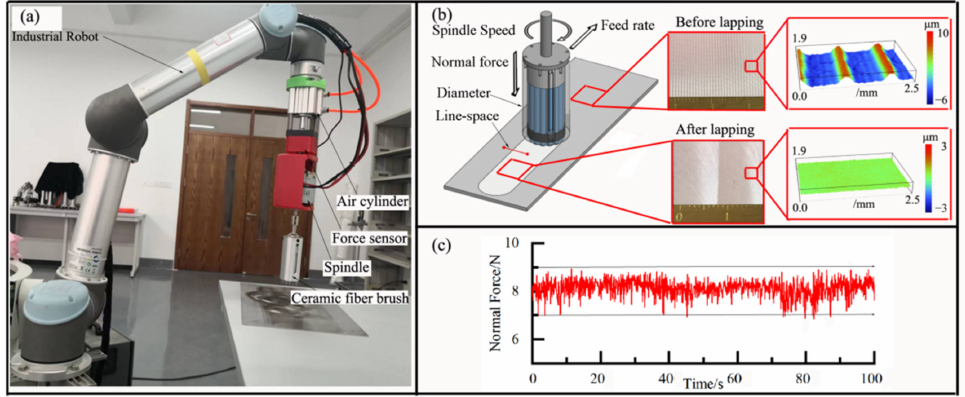
Figure 2. Robotic automatic lapping platform ( a ), process parameters ( b ), and constant of normal force ( c